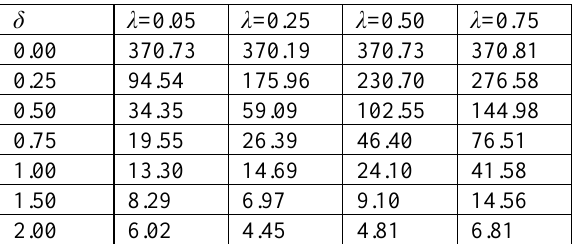
Table 4. ARLs for the EWMA median chart based on RSS scheme when